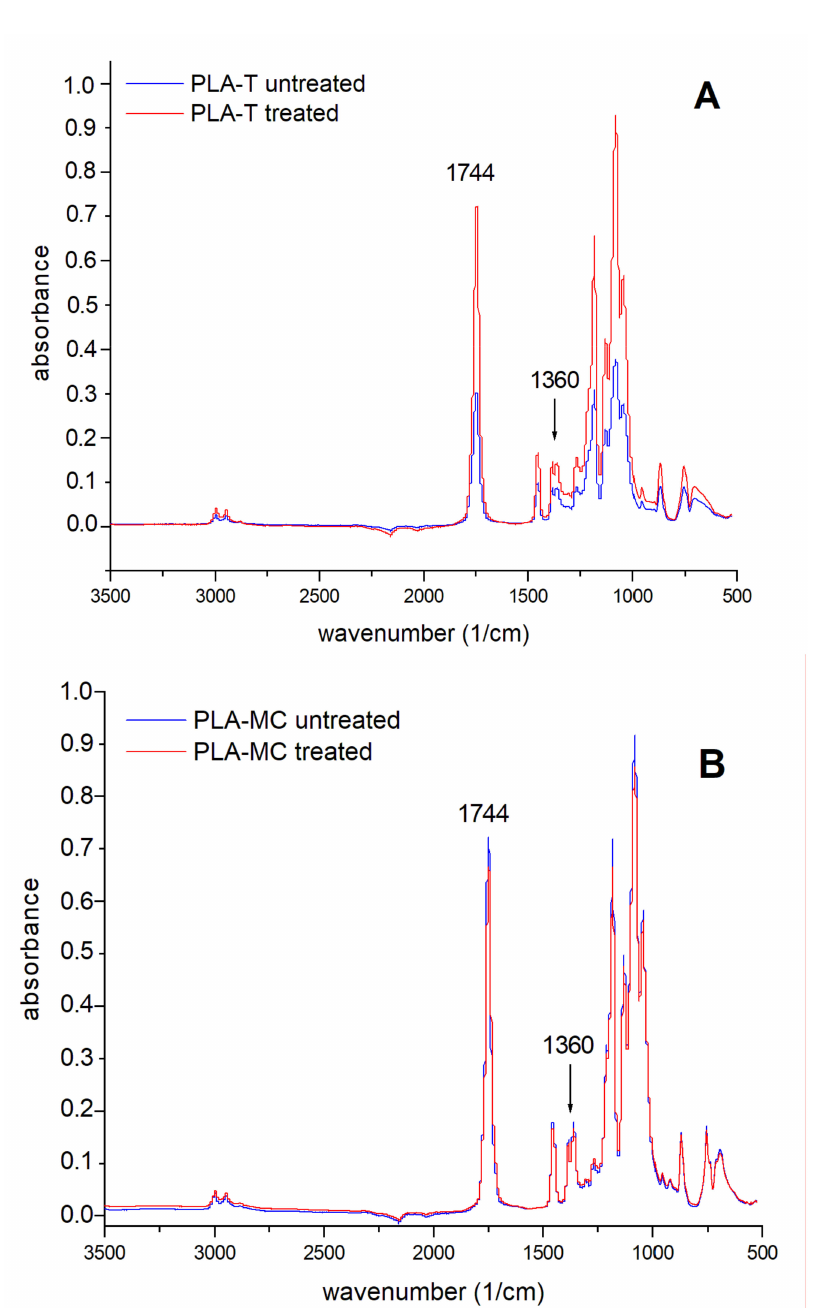
Figure 4. FTIR spectra: ( A ) thermoformed film (PLA-T) and ( B ) solution cast film